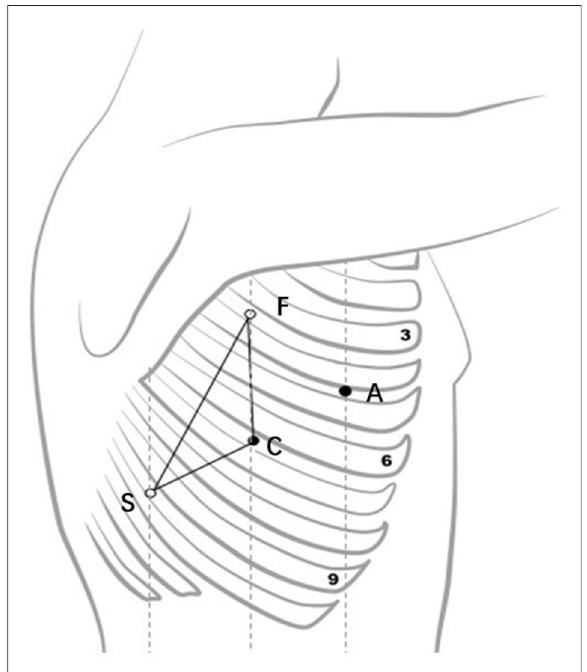
FIGURE 3 Robotic arm placement (an isosceles triangle). C, camera port; A, assistant port; F, fi rst robotic arm; S, second robotic